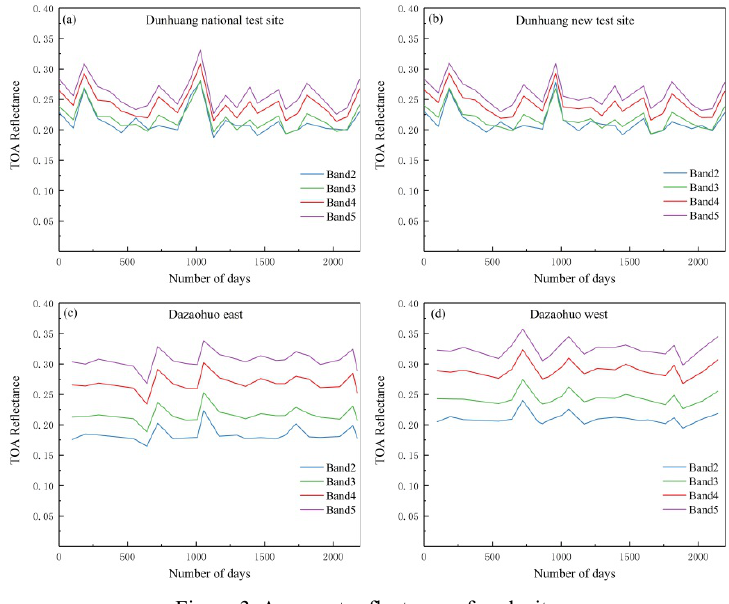
Figure 3. Apparent reflectance of each